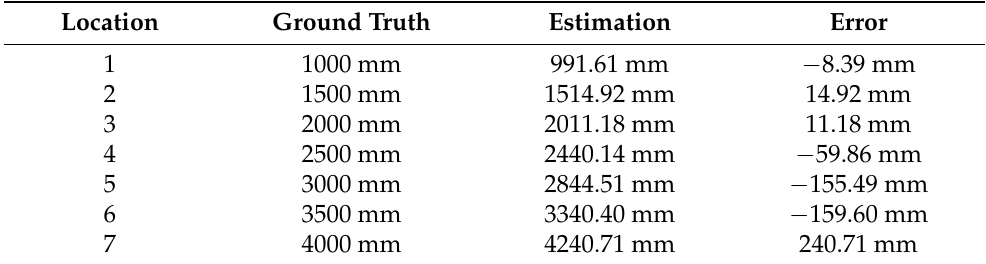
Table 1. The position estimates and the estimation errors at several locations. The errors are increased for the base points far away from the mobile